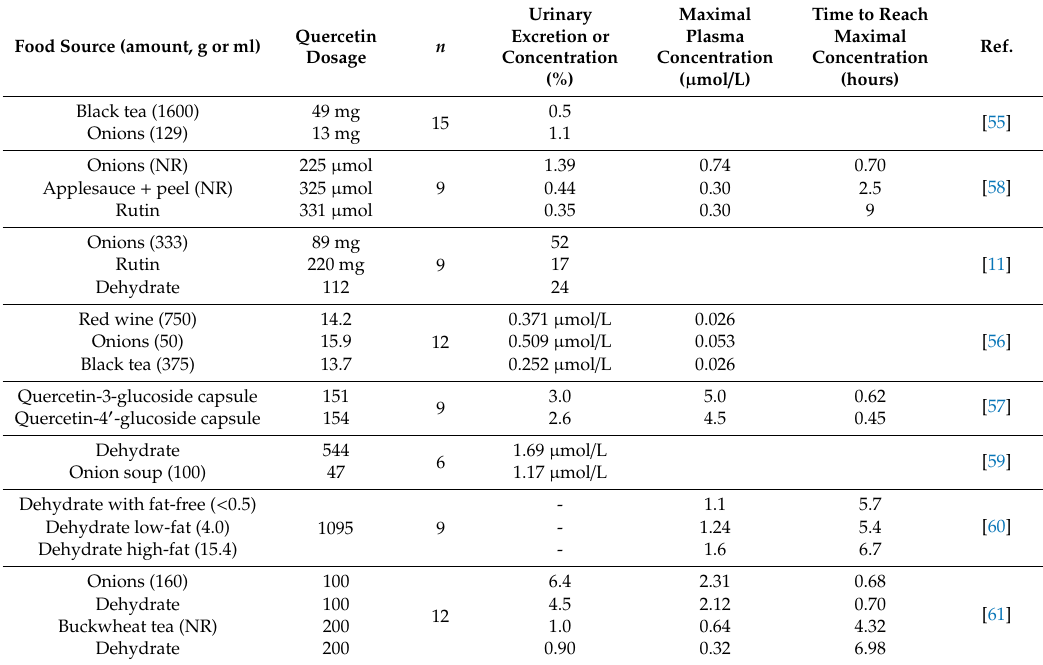
Table 3. Extent and rate of digestion and absorption di ff erent of quercetin forms from dietary sources.